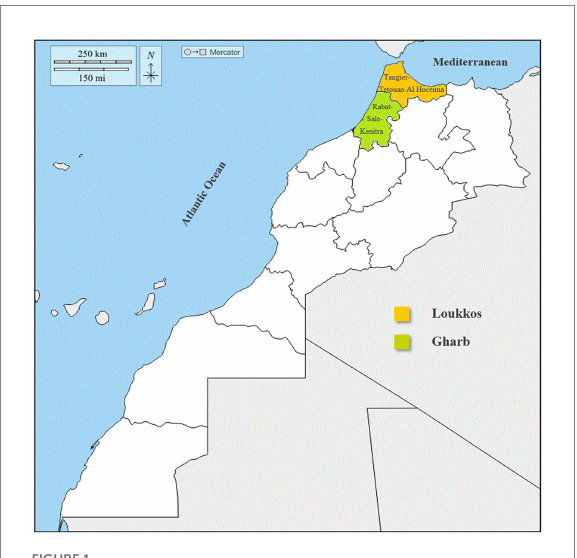
FIGURE 1 Sampling map of strawberries in the Loukkos and Gharb regions